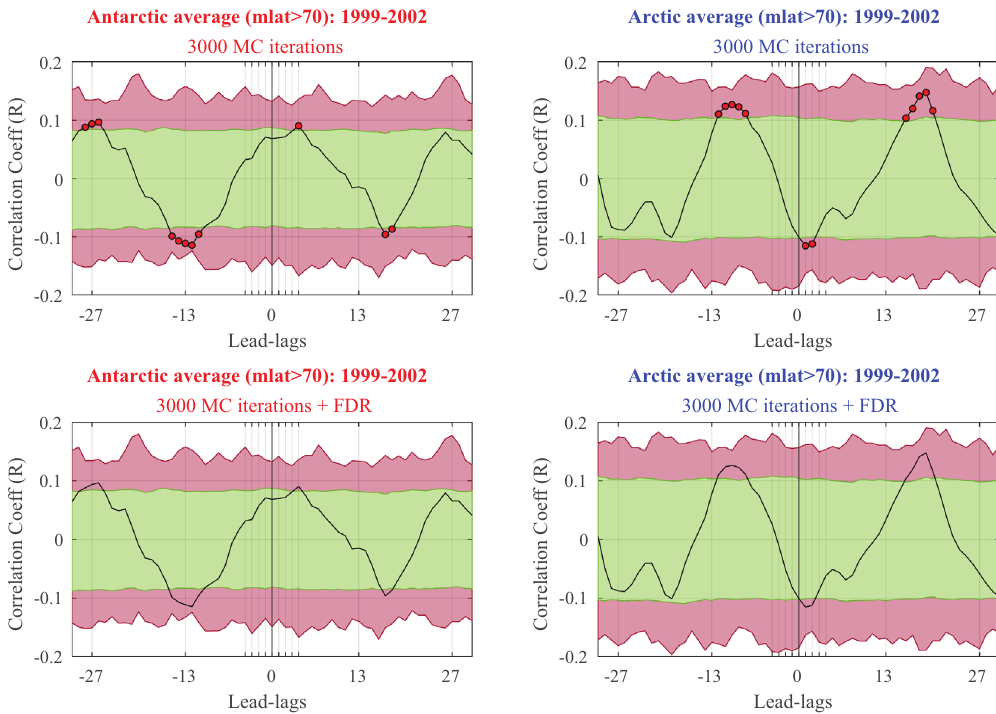
Fig. 6. Left panels : The signi fi cance level for the lead – lag correlation coef fi cients after 3000 MC-iterations for the period 1999 – 2002 in the SH. Dark red circles indicate 95% signi fi cance of the individual hypothesis tests ( top panel ). No signi fi cance is obtained after FDR. This is the case whether FDR is computed for the interval (cid:1) 27 to +27 ( N = 55), (cid:1) 13 to +13 ( N = 27) or +2 to +6 ( N = 5) lead – lags ( bottom panel ). Right panels : Same procedure, only for the NH ( top panel ). No signi fi cance is obtained after FDR. This is the case whether FDR is computed for the interval (cid:1) 27 to +27 ( N = 55), (cid:1) 13 to +13 ( N = 27) or (cid:1) 2 to +2 ( N = 5) lead – lags ( bottom panel